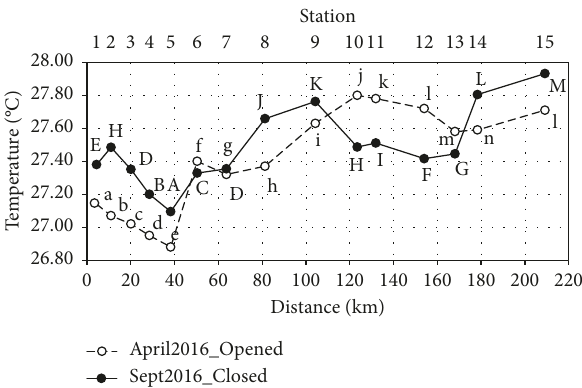
Figure 2: Temperature at the 15 stations downstream of Bakun Hydroelectric Dam during opened spillway ( o ) and closed spillway ( • ). The same letter indicates no significant difference ( p > 0 . 05). Table 3: Mean and standard deviation of the water quality pa- rameters in the Rajang River during opened and closed spillways.